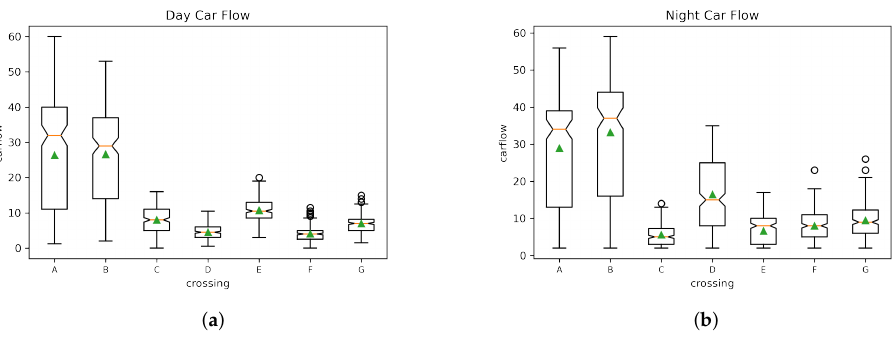
Figure 9. Box figure of car flow. ( a ) Box figure of car flow in morning rush hour. ( b ) Box figure of car flow in evening rush hour.